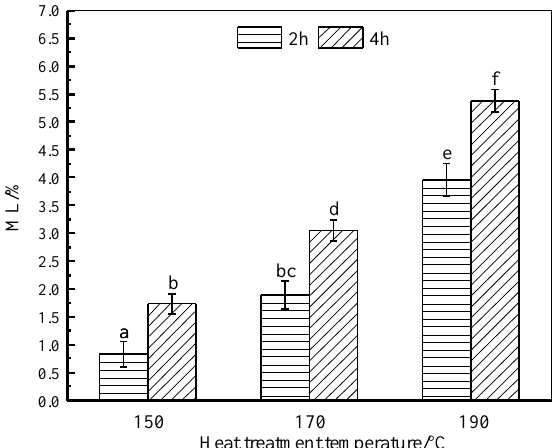
Figure 1. The ML of HT wood. Bars with different letters indicate significant differences ( p < 0.05) according to Duncan’s multiple range tests.